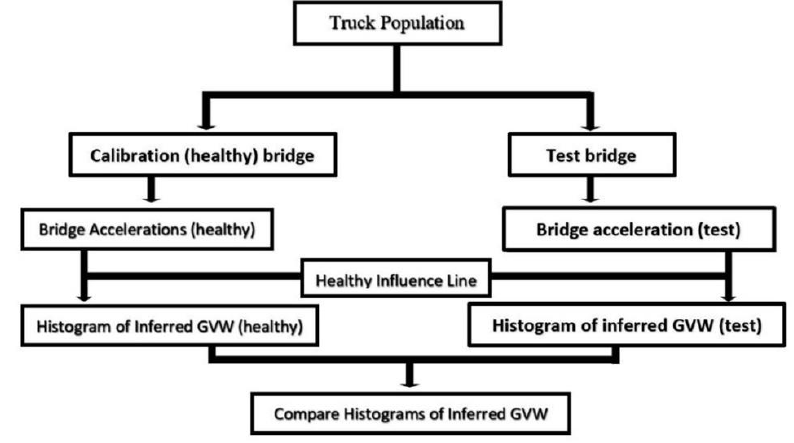
Figure 7. Schematic diagram of the methodology of bridge damage detection using the acceleration-based BWIM system.